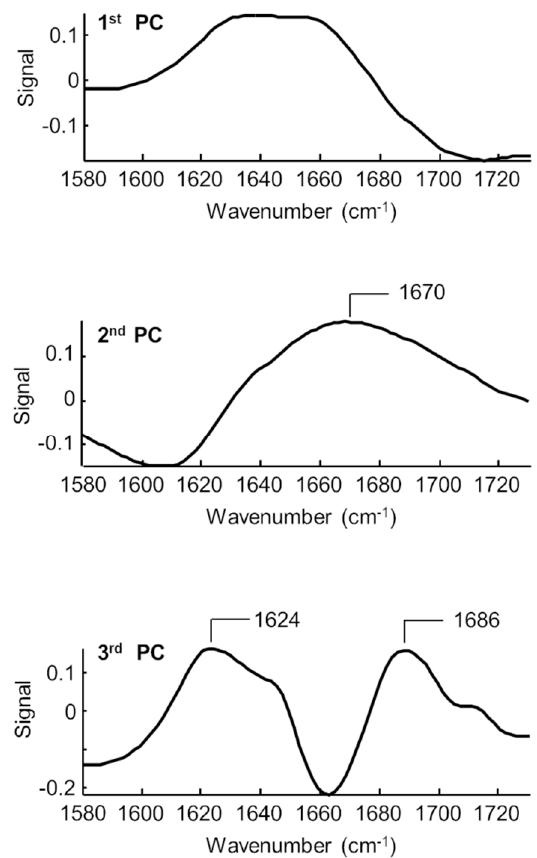
Figure 9. Loading plots of the first three PC’s of the PCA of the mineralized aortic valve leaflet, the mineralized AV prosthesis and the non-implanted prosthesis.